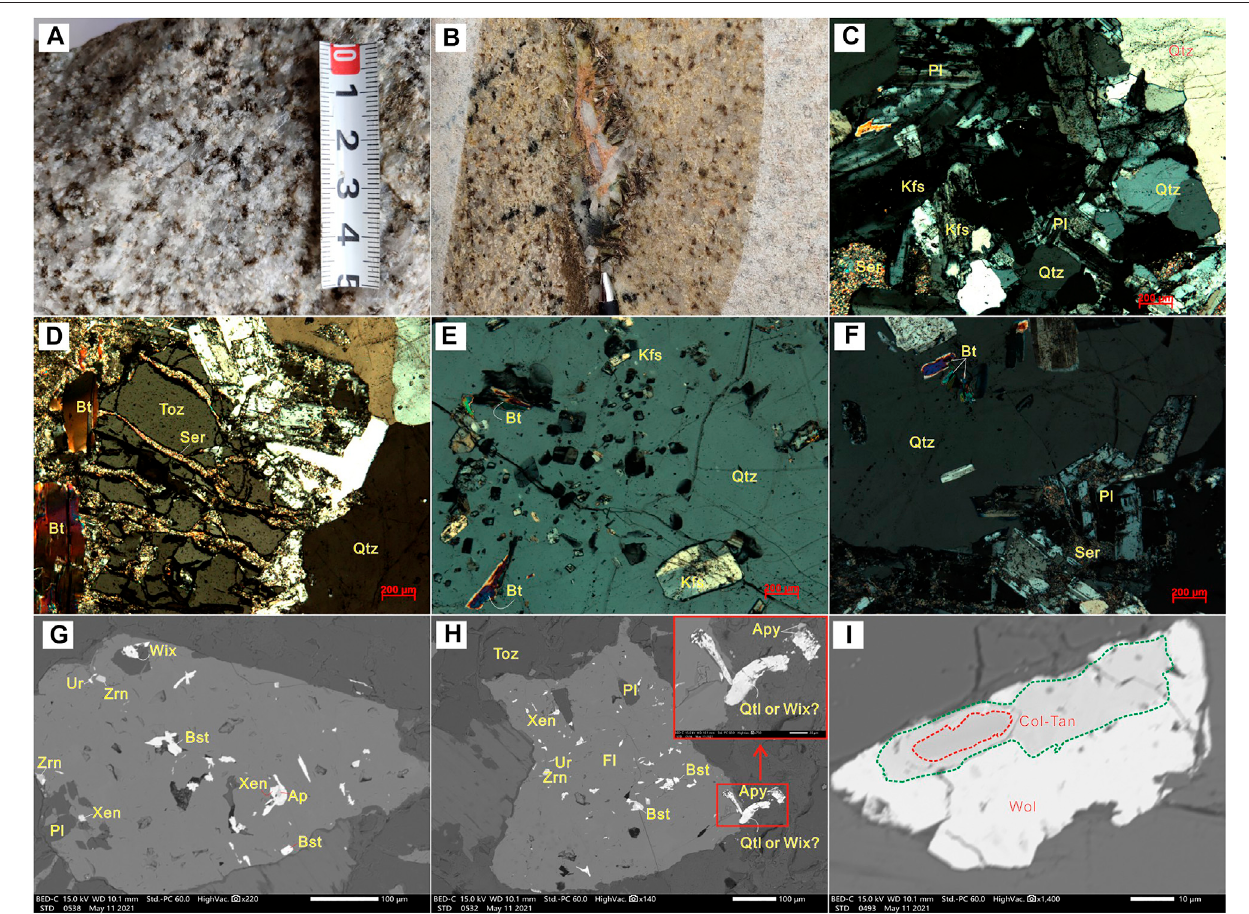
FIGURE 4 | Photographs of (A) topaz biotite monzogranite; (B) granitic pegmatite in medium-grained biotite monzogranite (C – F) Photomicrographs of topaz biotite monzogranite (G – H) Zircon, bastnaesite, uraninite, monazite, and arsenopyrite coexist within fl uorite; (I) Multigenerational zone-banded columbite-tantalite. Pl, plagioclase; Kfs, K-feldspar; Qtz, quartz; Bt, biotite; Toz, topaz; Mnz: monazite; Py, pyrite; Zrn, zircon; Bst, bastnasite; Xen, xenotime; Thr, thorite; Fl, fl uorite; Col-tan, columbite-tantalite; Wol, wolframite; Apy, arsenopyrite.